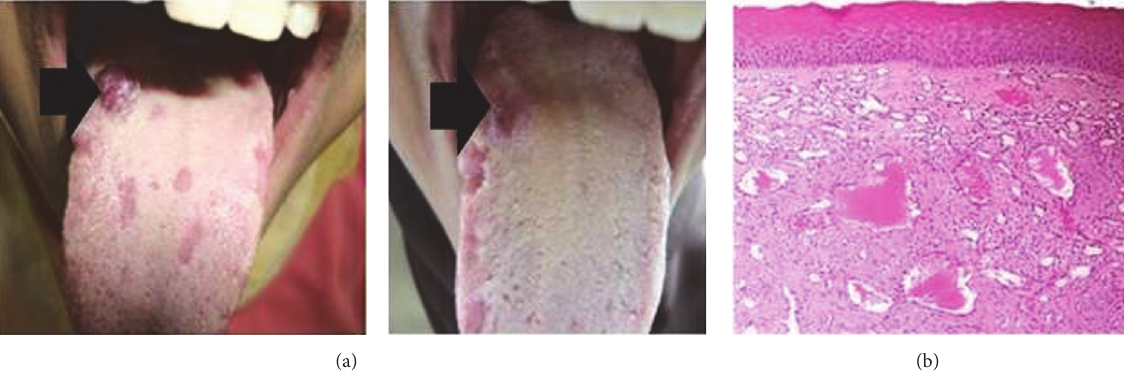
Figure 4: (a) Pre- and postoperative clinical pictures of lymphangioma in relation to the right posterior area of the dorsal surface of the tongue. (b) Photomicrograph of lymphangioma showing numerous subepithelial lymphatic vessels, some of which contain coagulated lymph (H&E ×